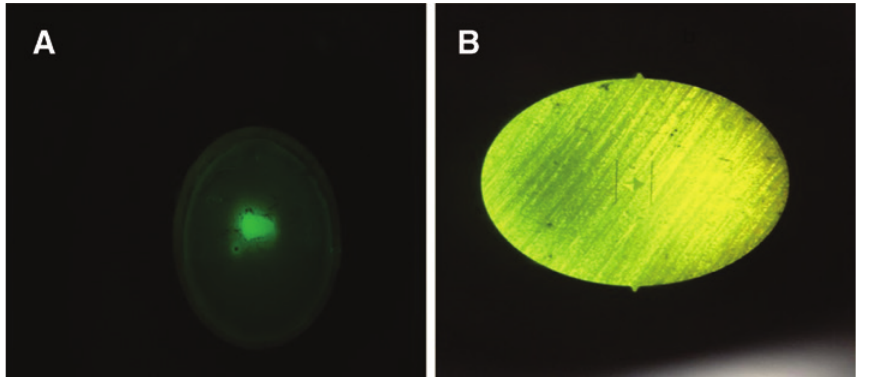
Figure 4: Presentation of the fluorescence in sound enamel deciduous tooth (A) and diamond pyramid indentation for Vickers hardness measurement (B).